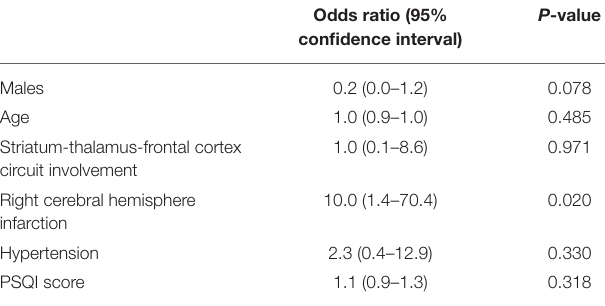
TABLE 3 | Multivariable analysis of fatigue after mild ischemic